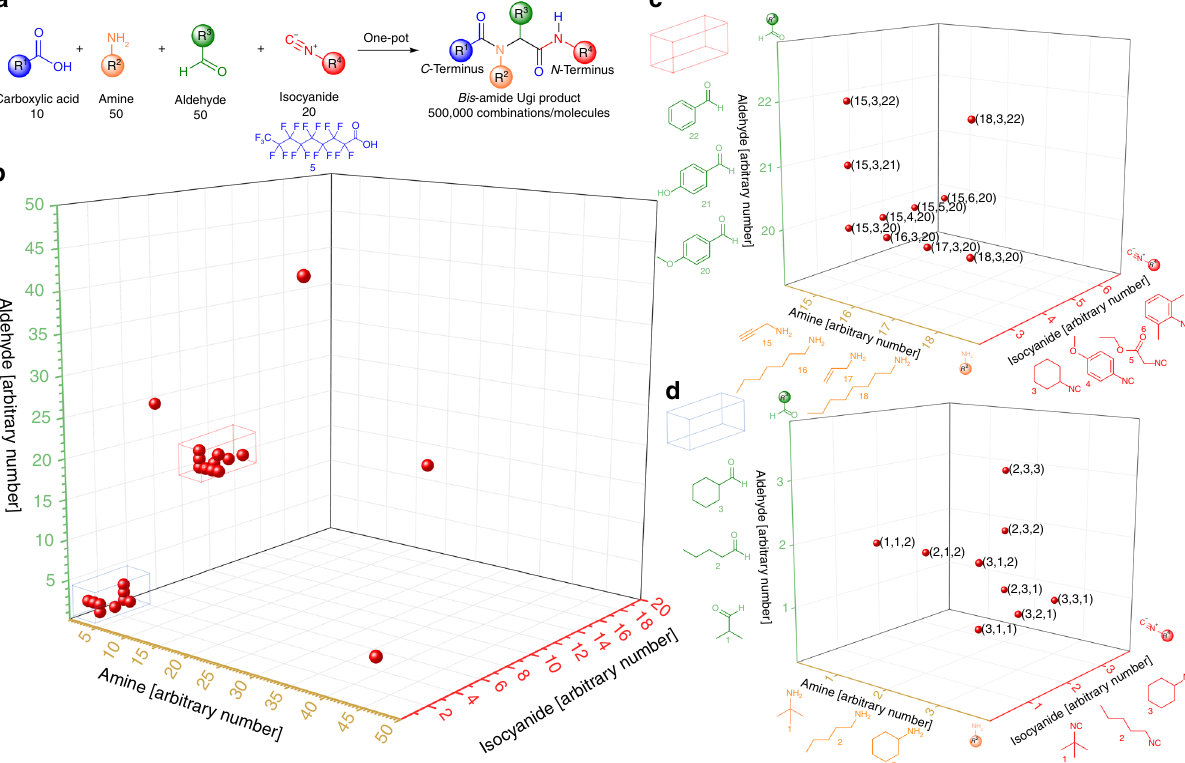
Fig. 1 Molecular keys. a Schematic representation of the Ugi reaction. The combinatorial scope of components considered in the exemplary list of components involves 500,000 molecules. b 3D plot of a set of molecules synthesized with per fl uorononaic acid (shorter and longer acids were also evaluated). The axes represent different functional groups. The numbers on the axes represent different components (i.e., sidechains). c , d Expansions of the two systematic variations highlighted by the red and blue box in b ,